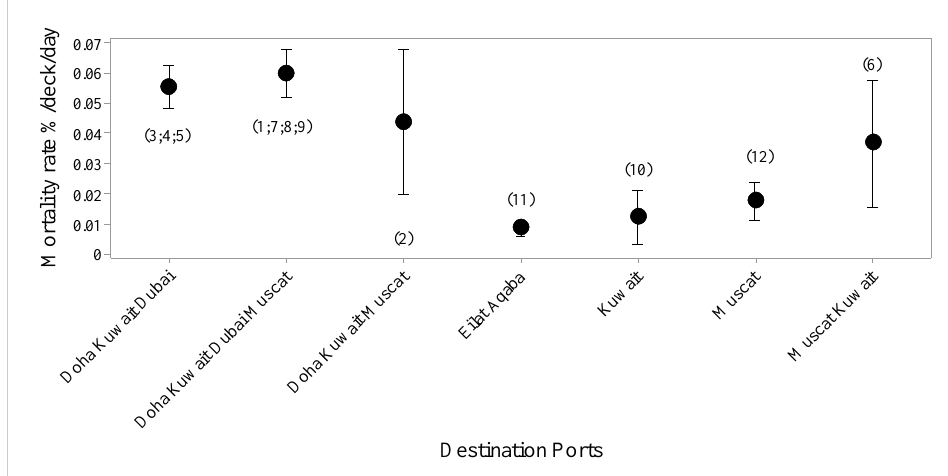
Figure 5. Mortality rate (% / deck / day with standard deviations) for voyages ( n = 12, voyage numbers in parentheses) o ffl oading at di ff erent